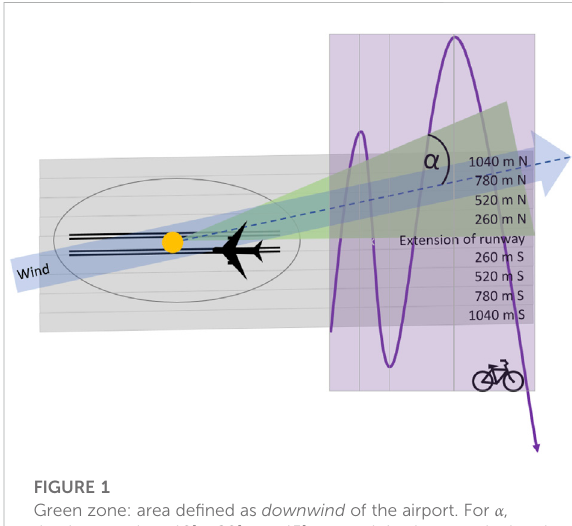
FIGURE 1 Green zone: area de fi ned as downwind of the airport. For α , thethreeangles±10 ° ,±20 ° ,or±45 ° areused.Anglesarecalculated in reference to the center of the airport (orange dot). Gray zone: area de fi ned as within the fl ight path . Zones are named according to their distance north or south of the extension of the runway. Purple zone: area covering the transects of the measurement route perpendicular to the extension of the